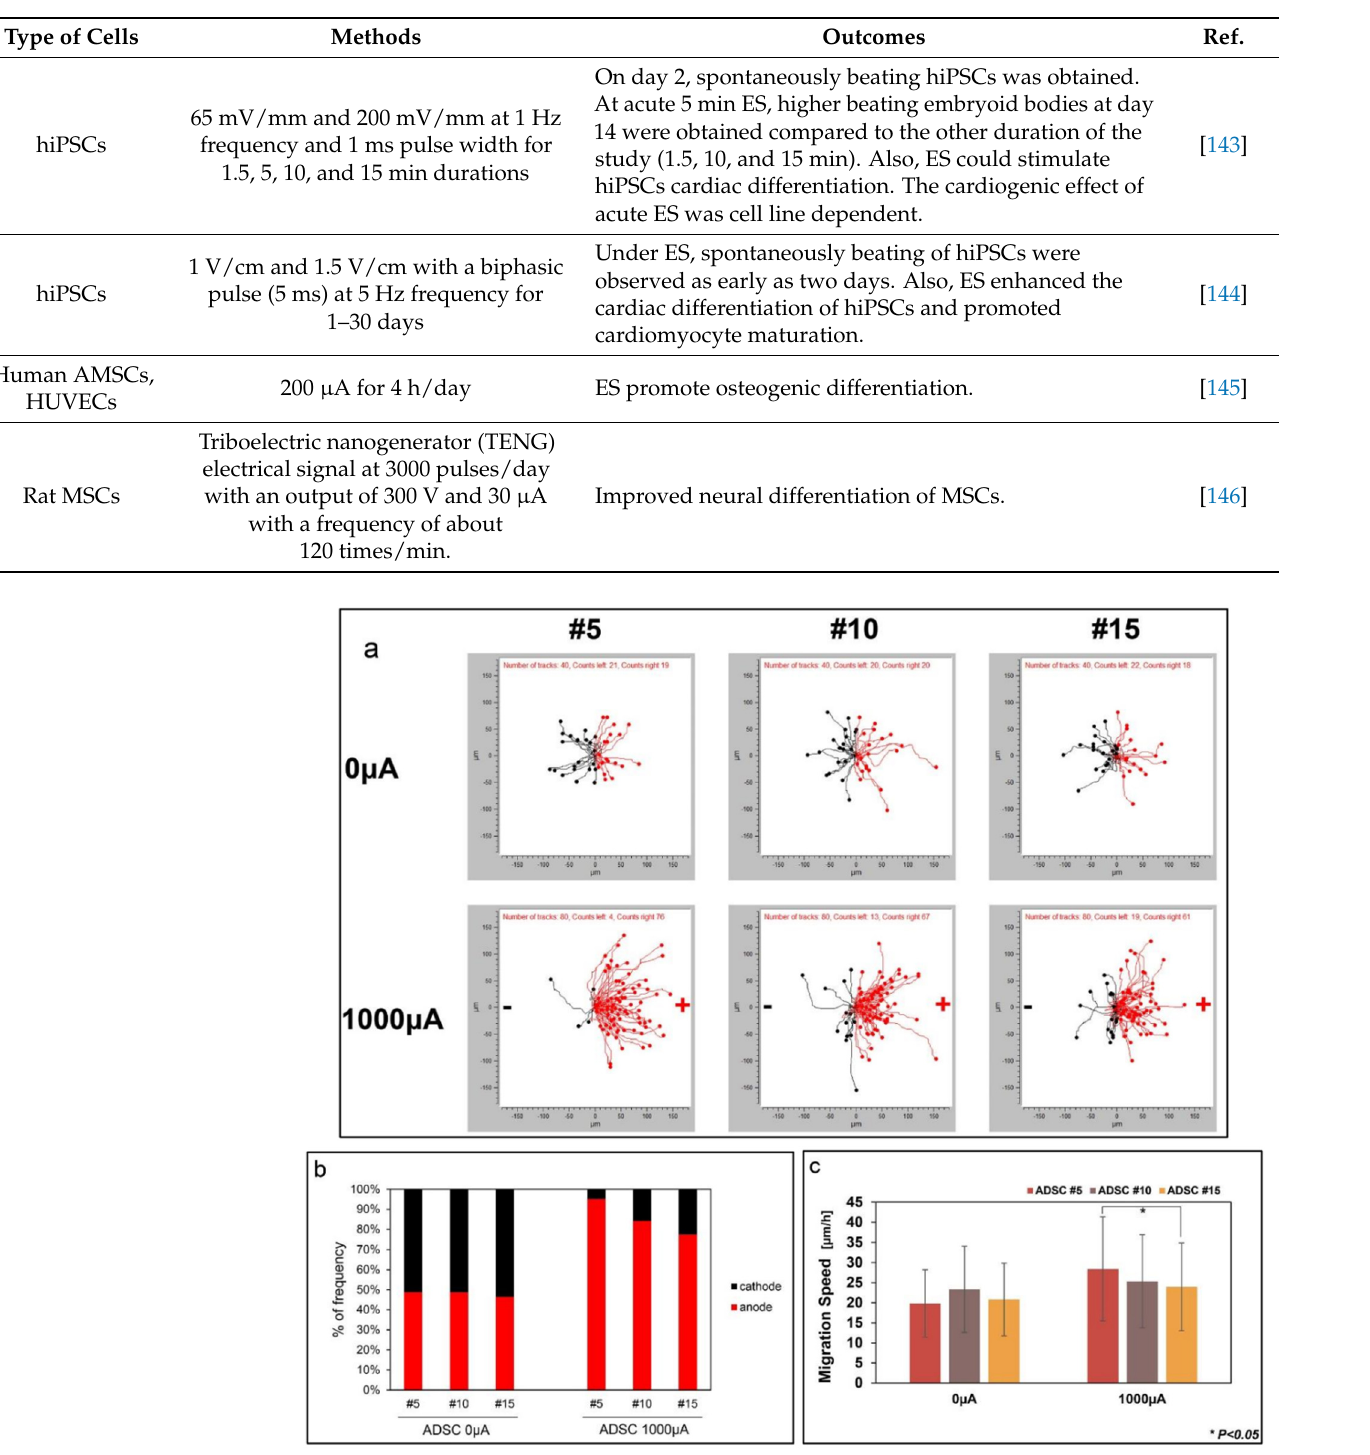
Figure 7. ADSCs migration by electrotaxis with increasing passage numbers. Reproduced with permission from Ref. [99]; copyright (2019), Elsevier. ( a ) ADSCs were manually tracked and cells migration was divided into the right (anode) and left (cathode). ( b ) Frequency of cell movement towards the anode and cathode. ( c ) Cell migration speed was measured at passages 5, 10, and 15 when direct current was applied to the cells. * p < 0.05.